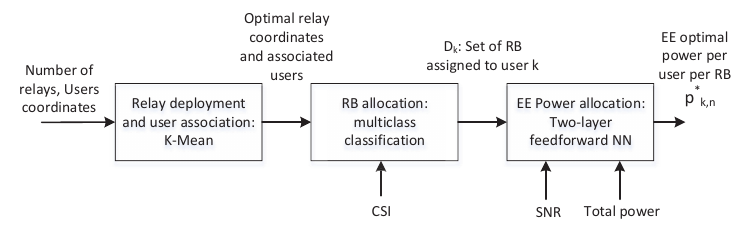
Figure 8. Block diagram of machine learning based resource and power